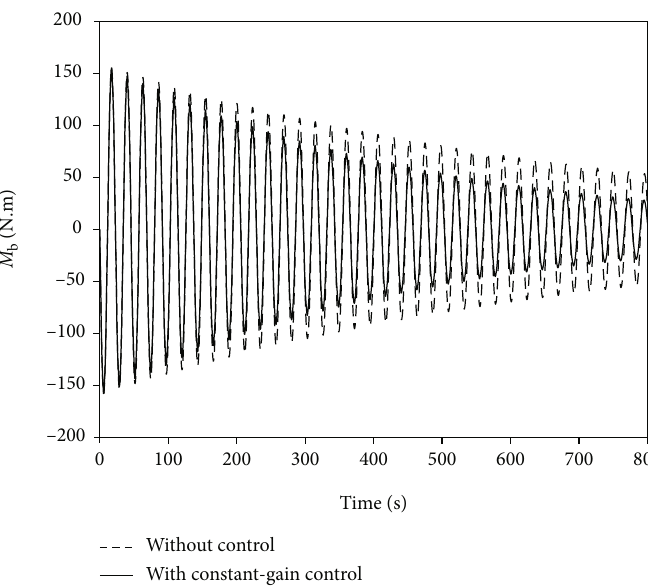
Figure 4: Response curve of the root bending moment with constant-gain control.